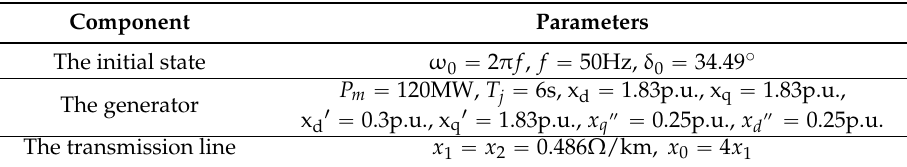
Table 1. The parameters of the SMIB system.